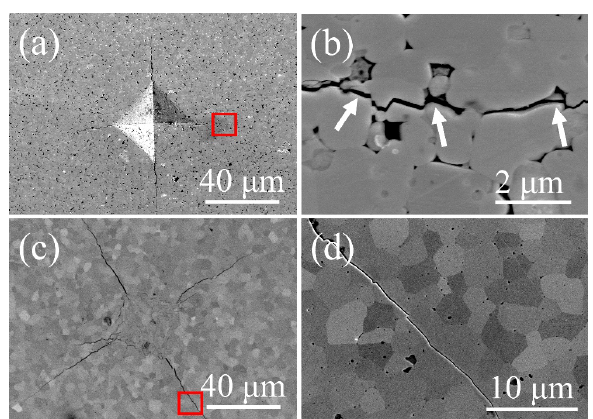
Fig. 10 Representative SEM images of the Vickers indentation (2 kg applied load): (a) HC1550-H and (c) H2000. SEM images of the typical crack paths induced by the Vickers indentation: (b) HC1550-H and (d) H2000. White arrows show the regions exhibiting crack